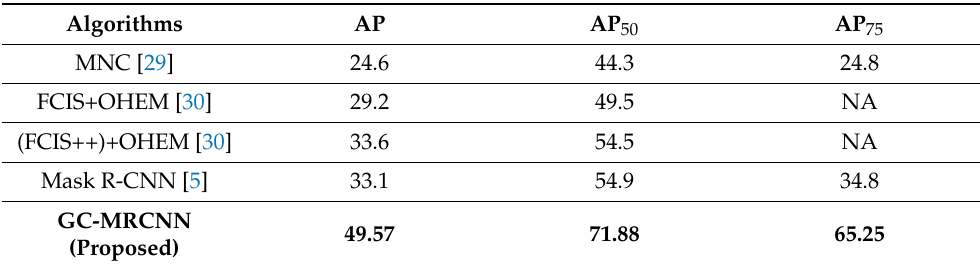
Table 3. Average over IoU Thresholds (AP) for different